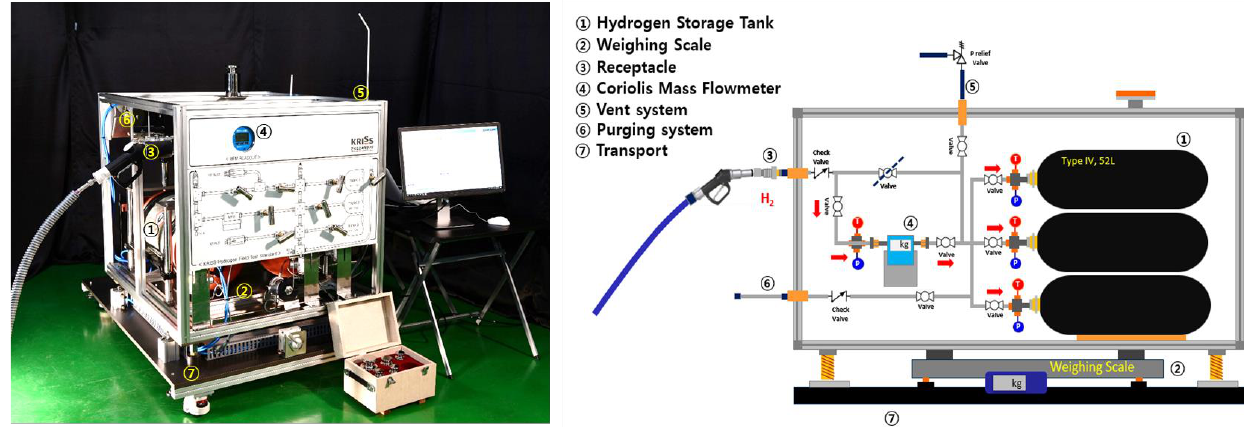
Figure 2. KRISS Hydrogen Field Test Standard (primary gravimetric system for flowmeters at hydrogen refueling stations).